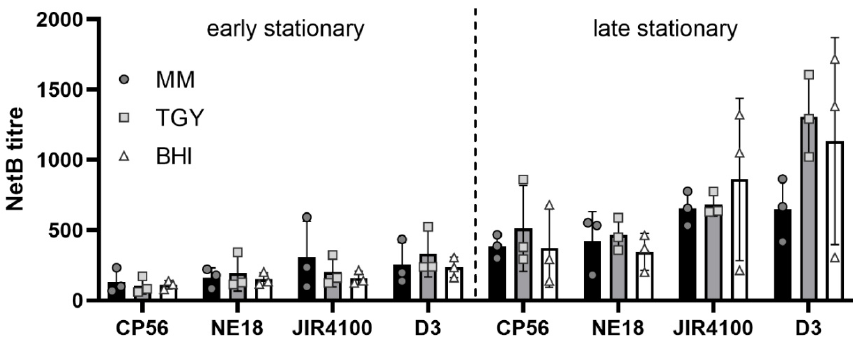
Figure A1. NetB titres after 7 h (early stationary phase) and 24 h (late stationary phase) growth of four NetB-positive strains in different media. The graph shows the NetB titre induced by CP56 and NE18 (both producing the consensus NetB protein), and JIR4100 or D3 (producing the A168T variant NetB protein) grown in either minimal medium (MM, black), tryptose glucose yeast extract medium (TGY, grey) or brain heart infusion broth (BHI, white). The NetB titre of each strain represents the supernatant dilution that induces 50% haemolysis.